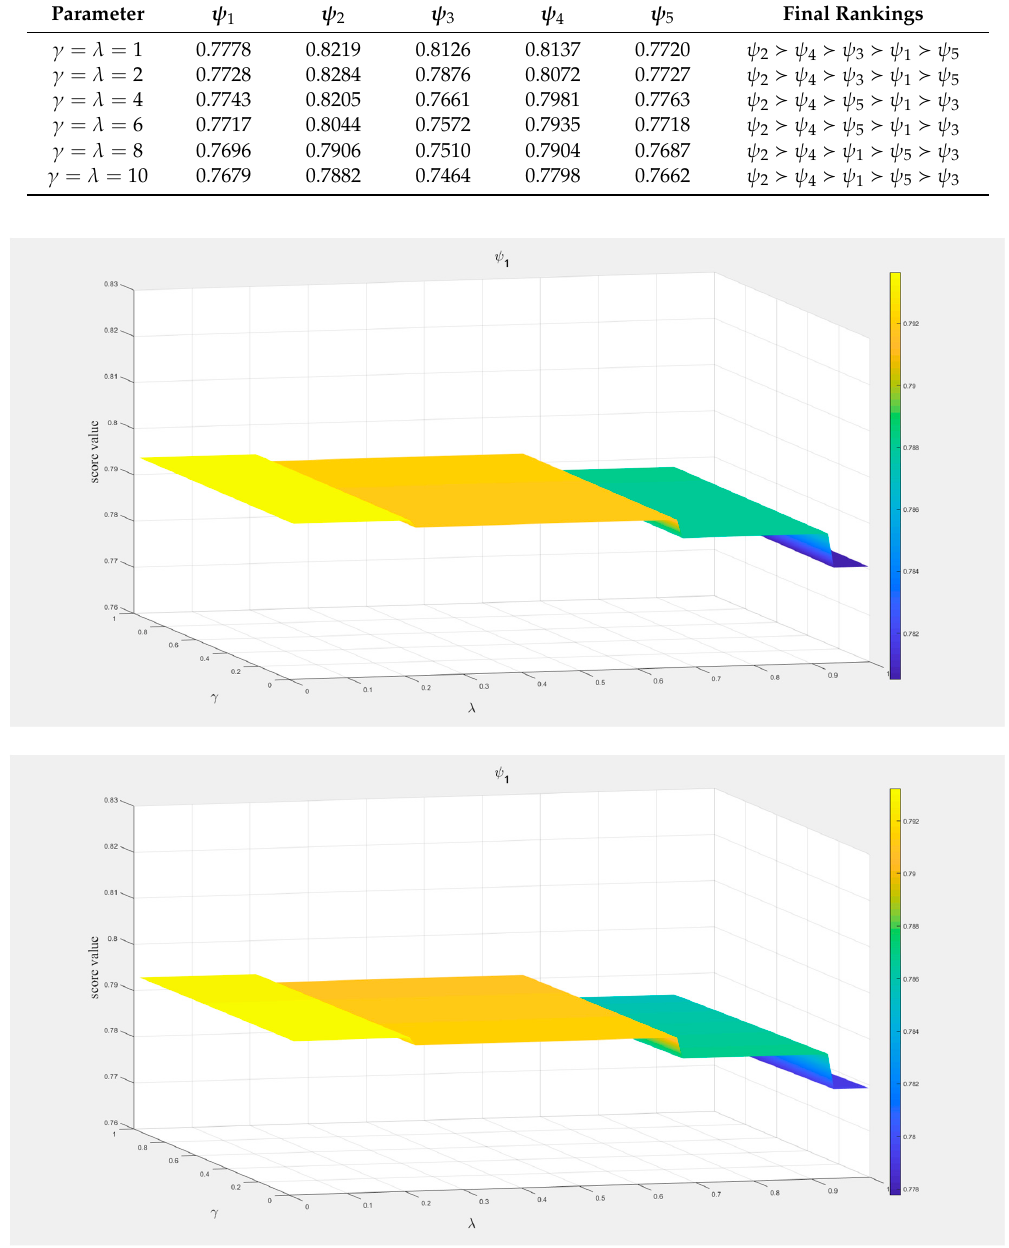
Figure 2. Score values